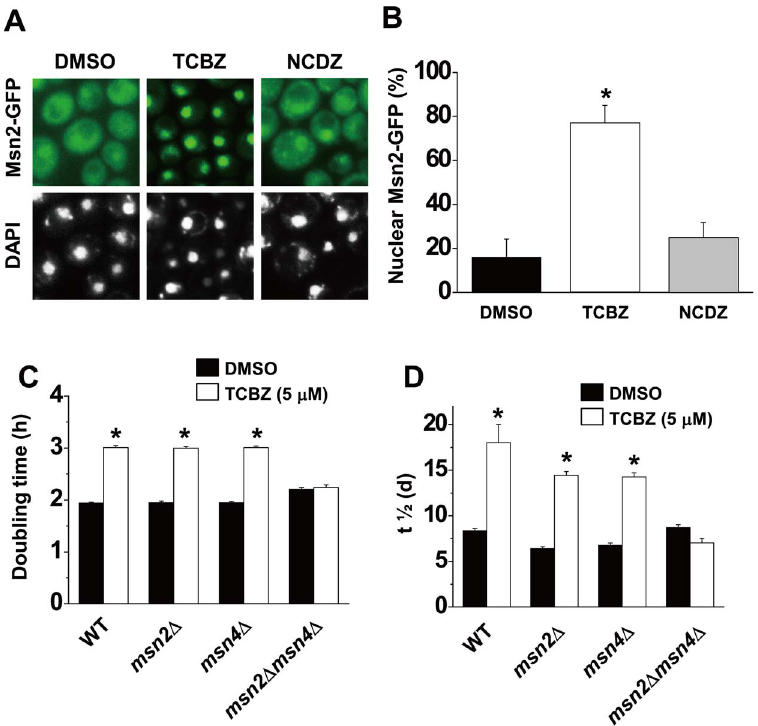
Figure 5. Triclabendazole activates Msn2/4 . (A) Triclabendazole activates nuclear localization of the Msn2. Msn2-GFP were pre-grown to A 600 =0.5–0.6, the indicated drug was added for 2 h, and cells were then visualized by fluorescence microscopy. Nuclei were visualized using DAPI. (B) Percent of cells with nuclear Msn2-GFP. Values were obtained from four independent experiments; the total number of cells counted was 300–350. Error bars are 6 SD. *, p , 0.001 (versus DMSO or nocodazole). (C) Doubling time. Indicated cells were inoculated in SC-glucose medium with triclabendazole or DMSO and incubated with shaking at 30 u C. Absorbance ( A 600 nm ) was measured every 3 h, and doubling time was calculated as described in the methods. Values are the mean 6 SD of the three independent experiments. *, p , 0.001 (versus DMSO), (D) Plot of mean life span ( t 1/ 2 ) values obtained from chronological aging assay of msn2 D , msn4 D , msn2 D msn4 D and wild-type cells. Values are the mean 6 SD of the three independent experiments. *, p , 0.001 (versus DMSO). TCBZ, triclabendazole; NCDZ,